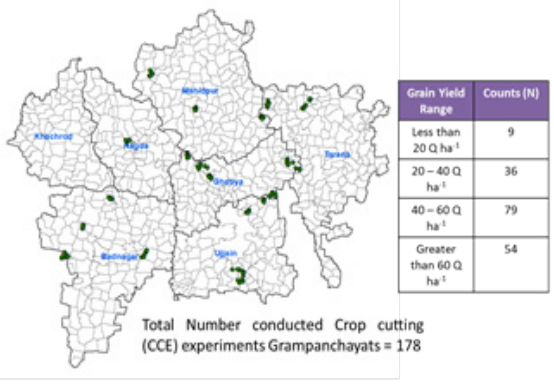
Fig. 3 Location of ground Yield data through CCE